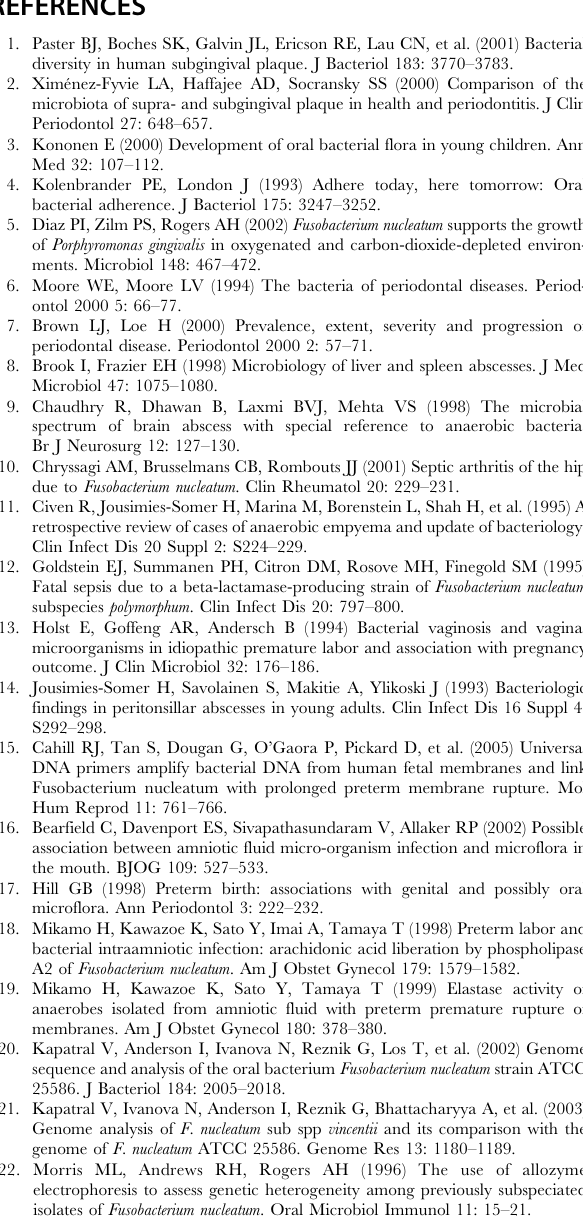
Table S2 Clusters of ORFs unique to FNP and not in FNN or